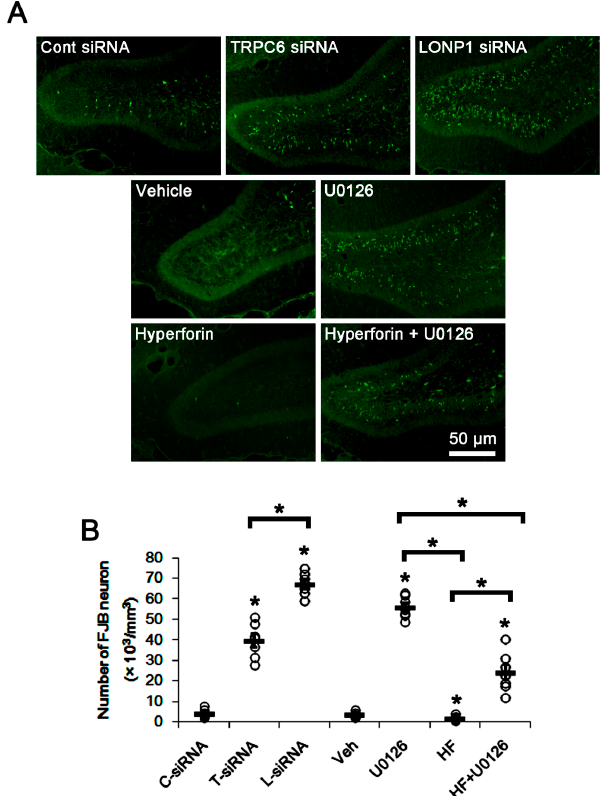
Figure 5. Effects of control siRNA, TRPC6 siRNA, LONP1 siRNA, U0126, hyperforin, and co-treatment of hyperforin and U0126 on SE-induced DGC degeneration. As compared to control siRNA (C-siRNA), TRPC6 siRNA (T-siRNA), LONP1 siRNA (L-siRNA) and U0126 induce massive DGC degeneration induced by SE. Hyperforin (HF) ameliorates SE-induced DGC damage, which is reversed by U0126 co-treatment (HF + U0126). ( A ) Representative images for FJB-positive degenerating DGC. ( B ) Quantification of the number of FJB-positive DGC. Open circles indicate each individual value. Horizontal bars indicate mean value (mean ± S.E.M.; * p < 0.05 vs. control siRNA or vehicle; one-way ANOVA; n = 7, respectively).